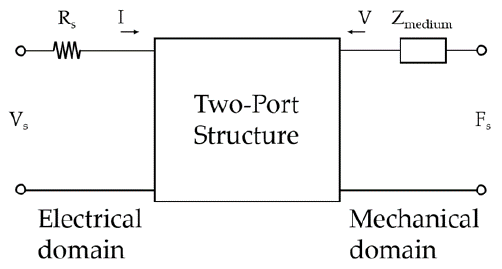
Figure 3. Generalized two-port network model [1] .